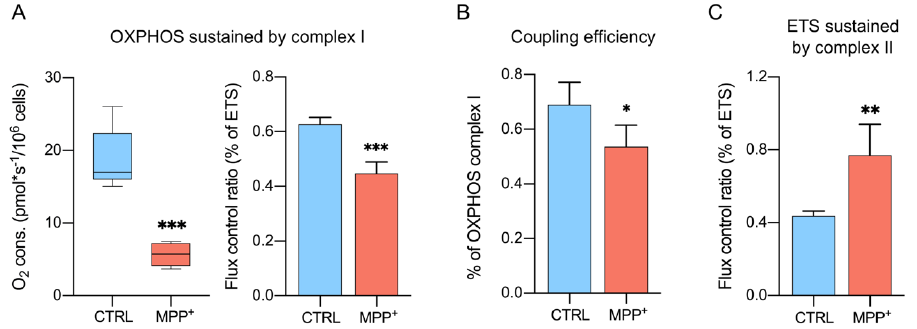
Figure 4. Coupling efficiency of different respiratory states. Rate of oxygen flux during ROUTINE ( A ), OXPHOS ( B ), and ETS ( C ) coupled with the ADP phosphorylation. Data are shown as the percentage of the reference state and expressed as means with standard deviation; * p < 0.05 and ** p < 0.01.